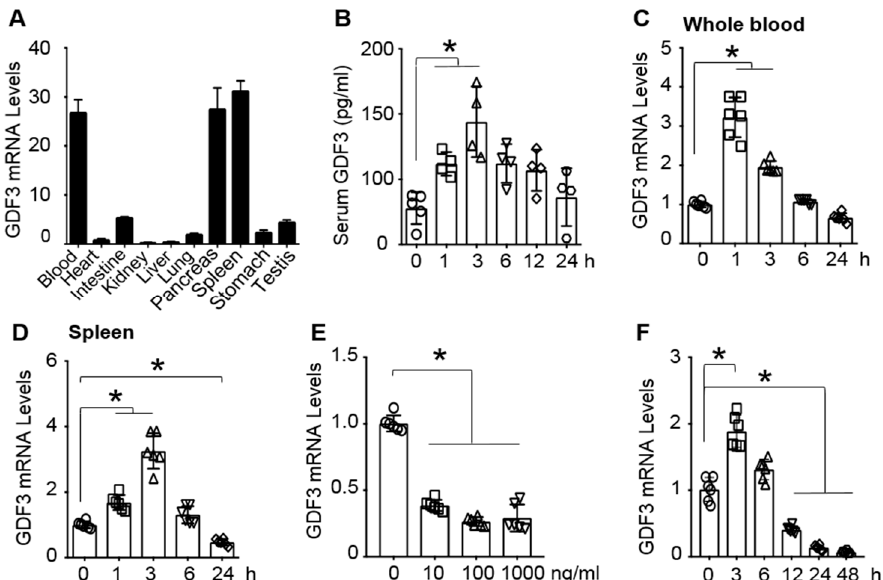
Figure 2. The dynamic expression of GDF3 in mice and macrophages treated with endotoxin. ( A ) mRNA levels of GDF3 in different tissues of mice, n = 4. GAPDH gene expression was used as the internal control. ( B ) Serum GDF3 levels are detected at indicated time points in mice after LPS (10mg/kg) injection (*, p < 0.05; n = 4). mRNA levels of GDF3 were determined in ( C ) whole blood and ( D ) spleens of LPS-injected mice (*, p < 0.05; n = 6). ( E ) LPS-dose response and ( F ) time course of GDF3 expression in BMDMs, where indicated, ( E ) total RNAs were collected at 24 h after LPS exposure (*, p < 0.05) and ( F ) BMDMs were pre-treated with LPS (10 ng/mL) (*, p < 0.05; n = 4). Similar results were obtained in other two independent experiments.